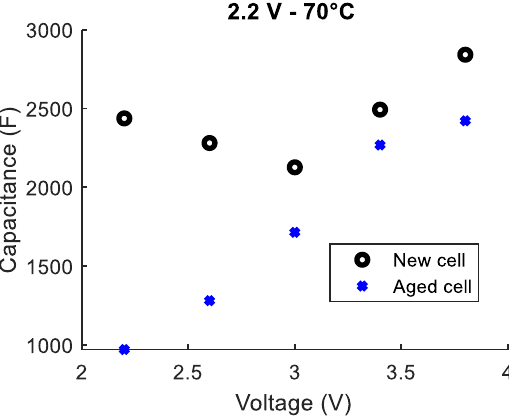
Figure 5. Comparison between the capacitances of a LiC, measured at 25 °C, before and after aging at 2.2 V and 70 °C for 20 months.